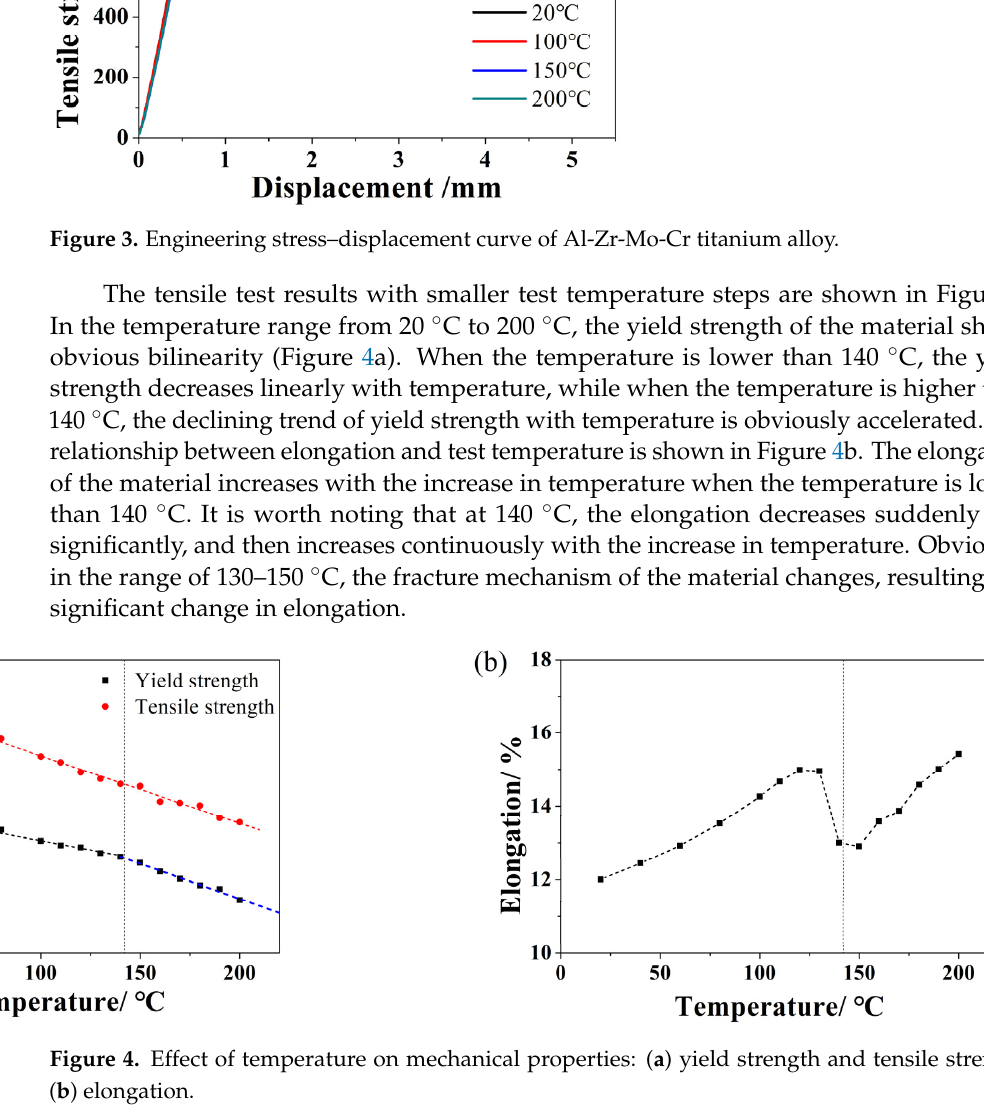
Figure 4. Effect of temperature on mechanical properties: ( a ) yield strength and tensile strength; ( b ) elongation.